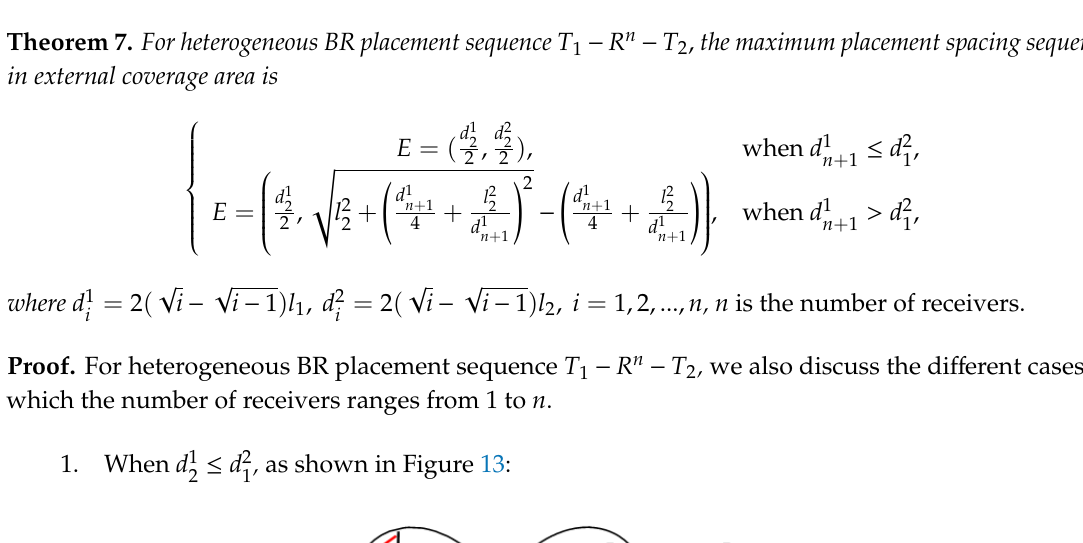
1 2 ( , ) T T d d  when . 2 1 ≤ d 2 . 2 1